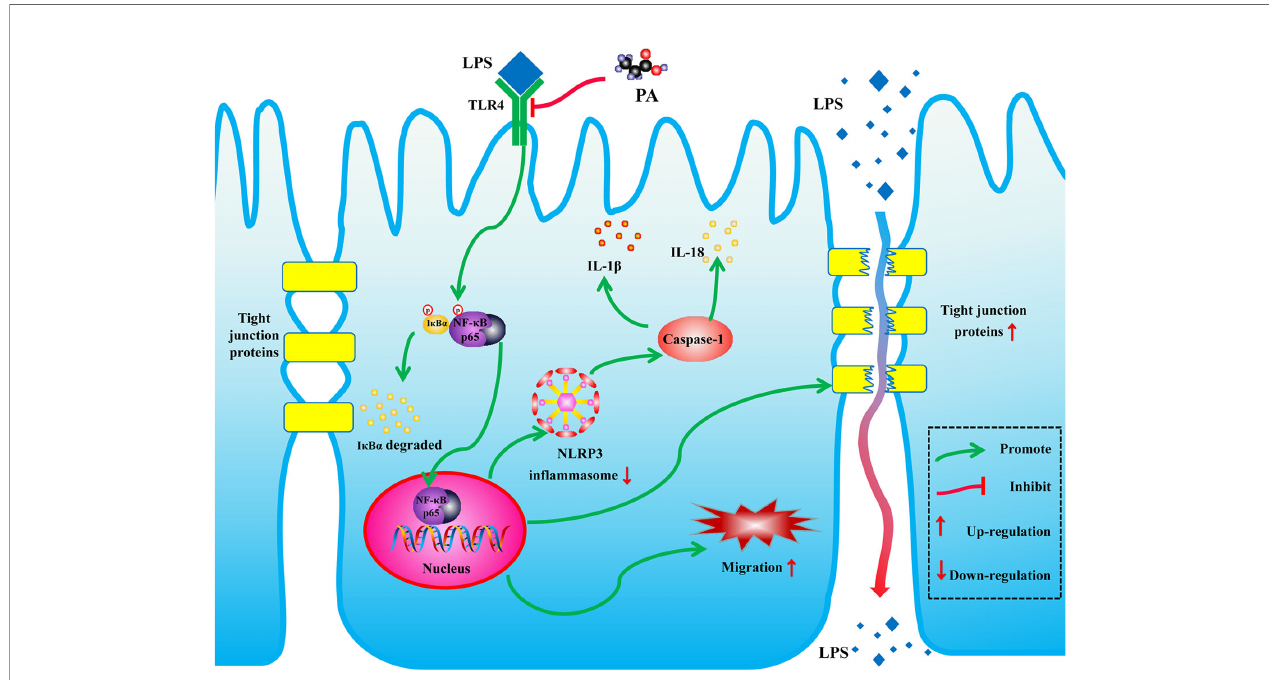
FIGURE 9 | Schematic of the potential protective effects of PA in LPS-induced intestinal barrier dysfunction. PA is an effective substance that could prevent the LPS-induced intestinal barrier dysfunction via TLR4/NF- k B